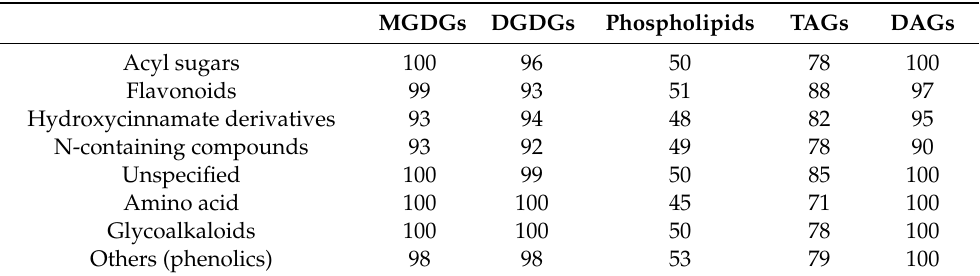
Table 1. Percentage of positive correlations between lipids and secondary metabolites.